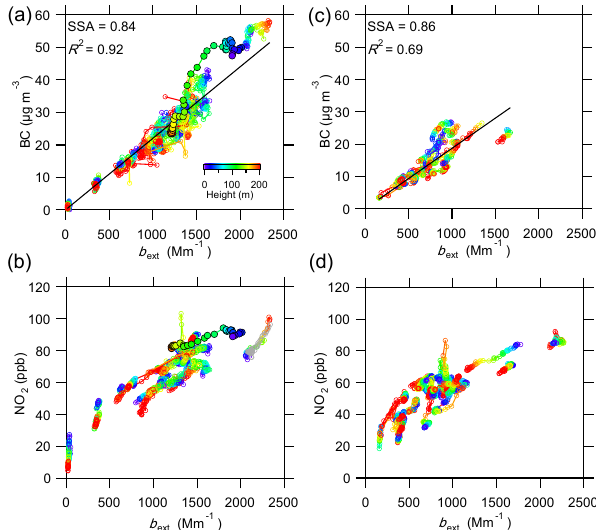
Figure 8. Correlations between BC and b ext , NO 2 and b ext for all vertical profiles in (a, b) November and (c, d) January. The data points are color coded by the heights. The solid circles in panels (a) and (b) are data points for